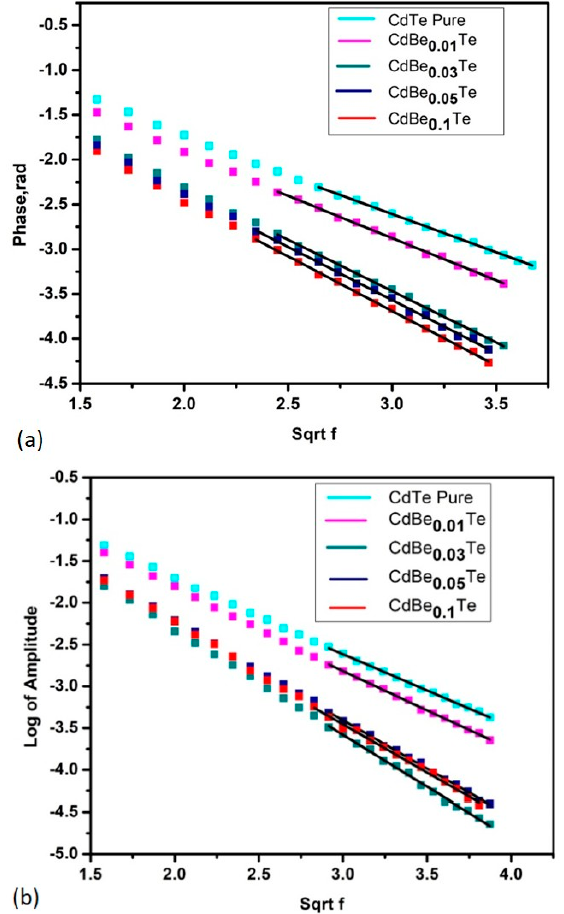
Figure 3 . Phase ( a ) and amplitude ( b ) characteristics of the CdBeTe samples for all Be content in case of back configuration. Squares refer to experimental points. Lines are linear fits.